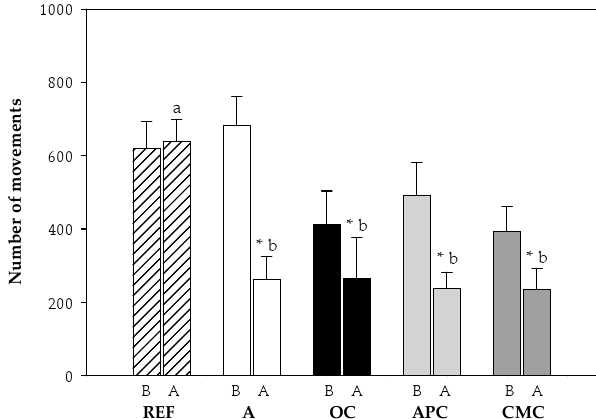
Figure 4. Number of movements during the active period (10 h of darkness) before (B) and after (A) intranasal challenge. REF: healthy animals fed standard diet; A: asthmatic animals fed standard diet; OC: asthmatic animals fed with ordinary cocoa-enriched diet; APC: asthmatic animals fed with “Amazonas Peru” cocoa-enriched diet; CMC: asthmatic animals fed with “Criollo de Montaña” cocoa-enriched diet. Results are shown as mean ± standard error ( N = 9). * represents statistical differences from individual values before challenge (paired t-test) ( p < 0.05). Values not sharing letters denote significant differences between groups ( p < 0.01) while values sharing the same letter did not differ.